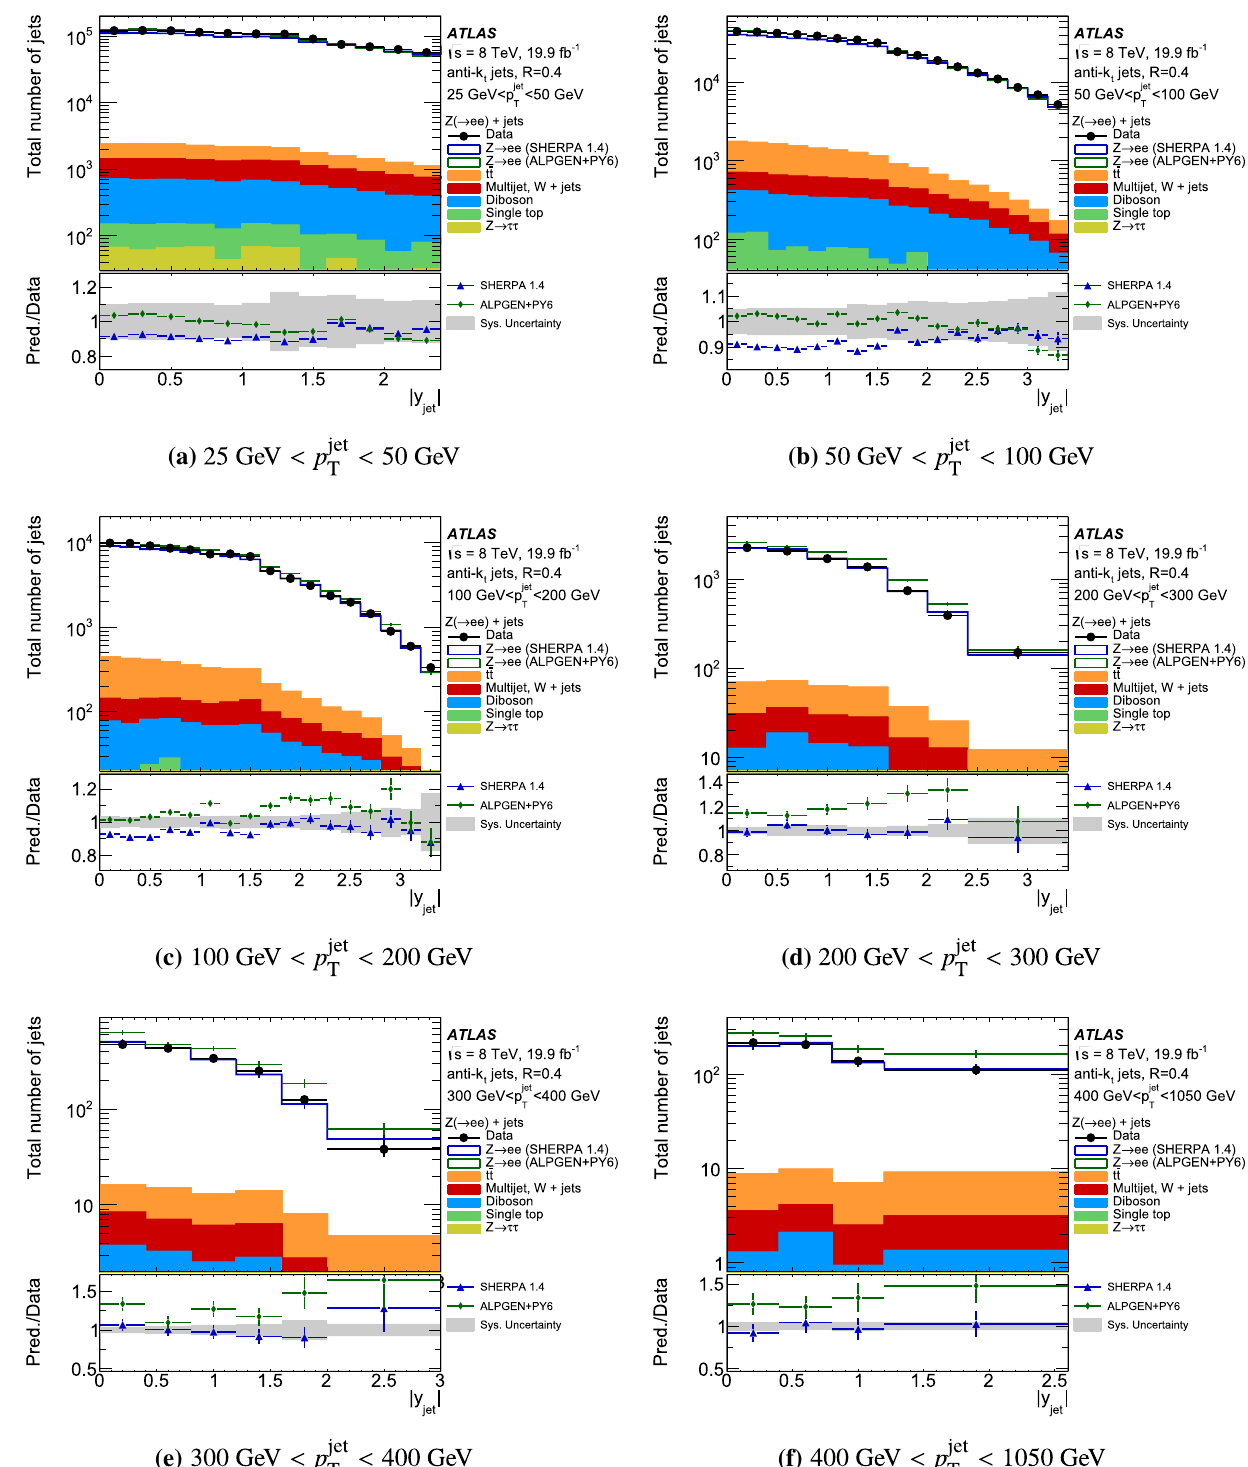
Fig. 1 The total number of jets in Z + jets events as a function of | y jet | in p jet binsfortheintegratedluminosityof19 . 9fb − 1 .Dataarepresented T with markers. The filled areas correspond to the backgrounds stacked. Allbackgroundsareaddedtothe Z + jets Sherpa and Alpgen+Pythia